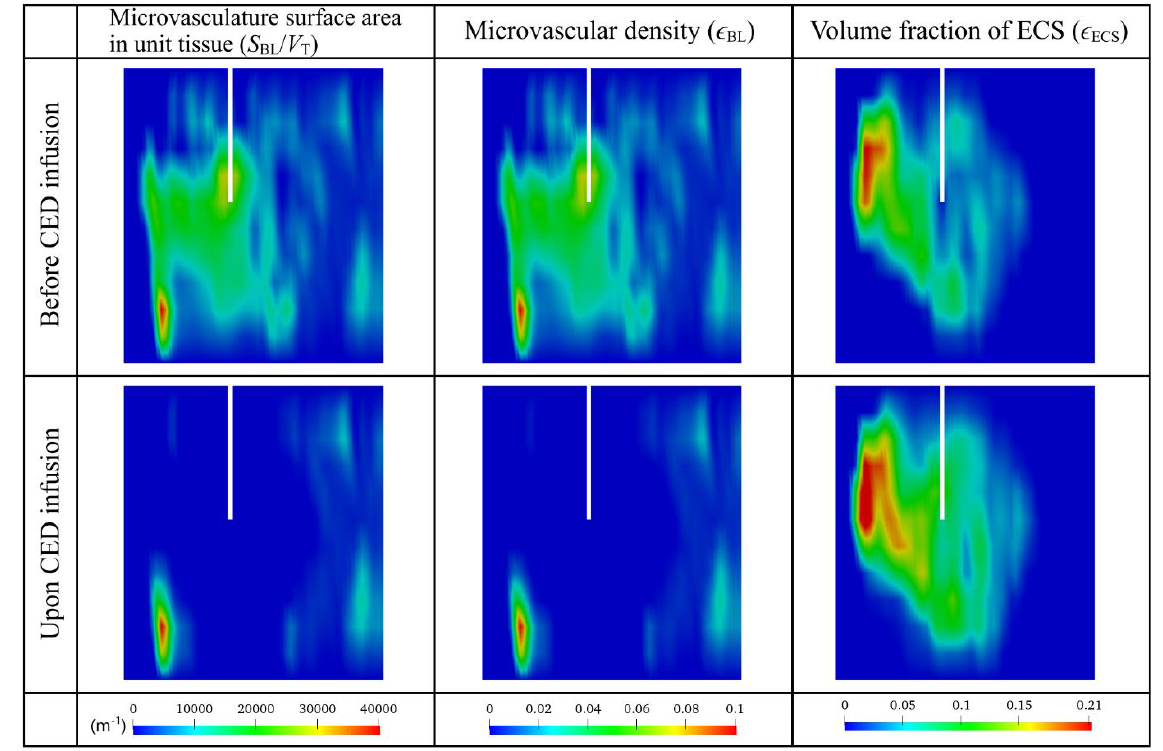
Figure 7. Distribution of tissue biological properties before and after the combination therapy. Results in the upper and lower panels are taken at time zero and Day 3, respectively.